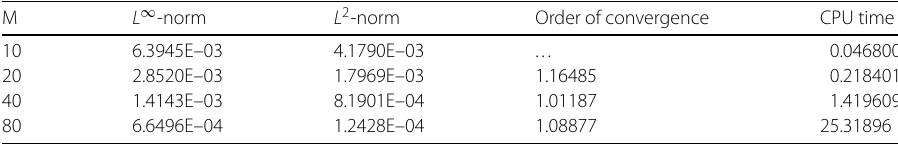
at T = 0.5 for Problem 3 M